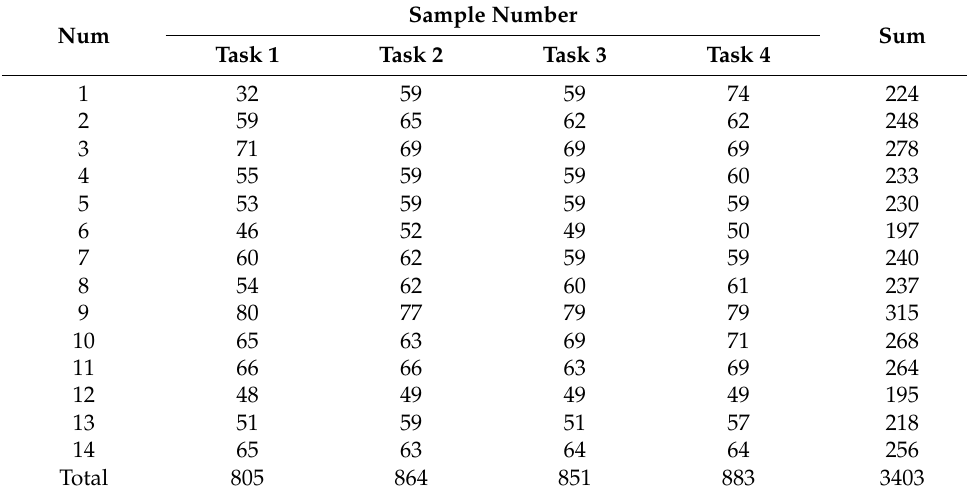
Figure 5. Schematic diagram of signal segmentation. Table 4. Sample size of each subject under four types of tasks. Table 4. Sample size of each subject under four types of Table 4. Sample size of each subject under four types of tasks.